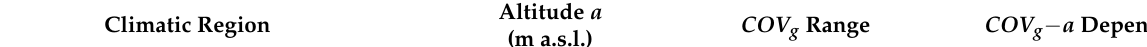
Alpine region (except for the German